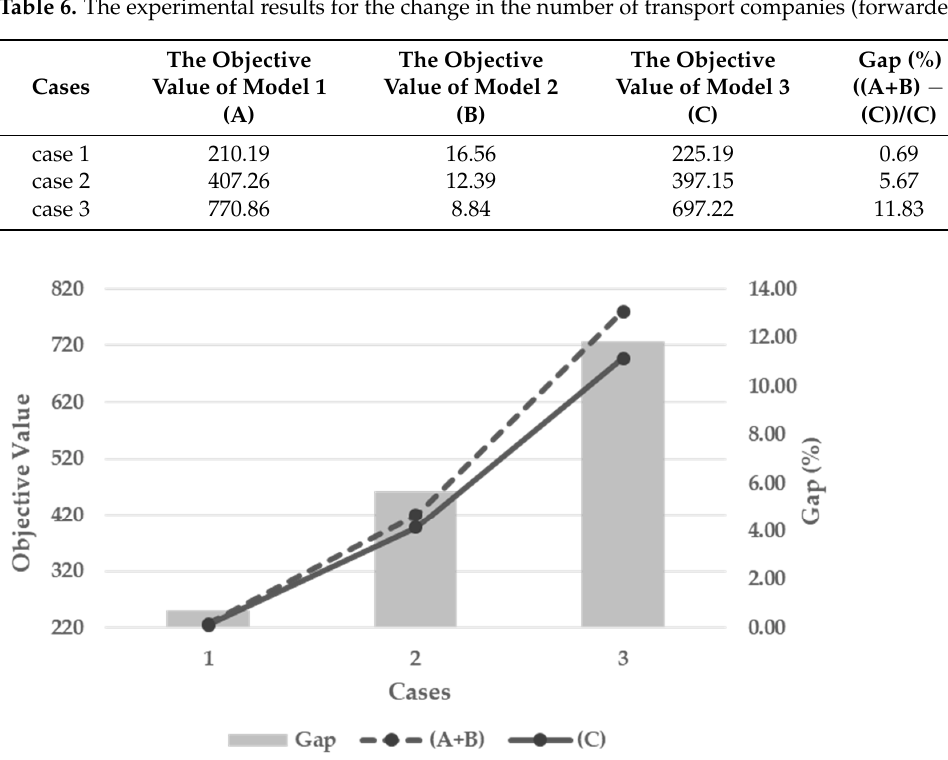
Table 5. Input parameters for the change in the number of transport companies (forwarders).